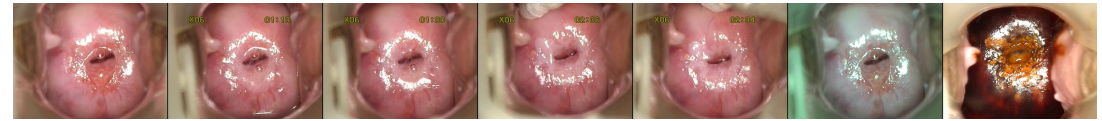
Figure 1. Dataset sample: the first five images correspond to the application of the acetic acid solution; the image from the penultimate column is viewed through a green lens; and the image in the last column displays the application of iodine solution. The sample corresponds to Class 2 (Cervical Intraepithelial Neoplasia 2/3). In the images, it can be observed how the area below the cervix opening turns whiter after the application of the acetic acid